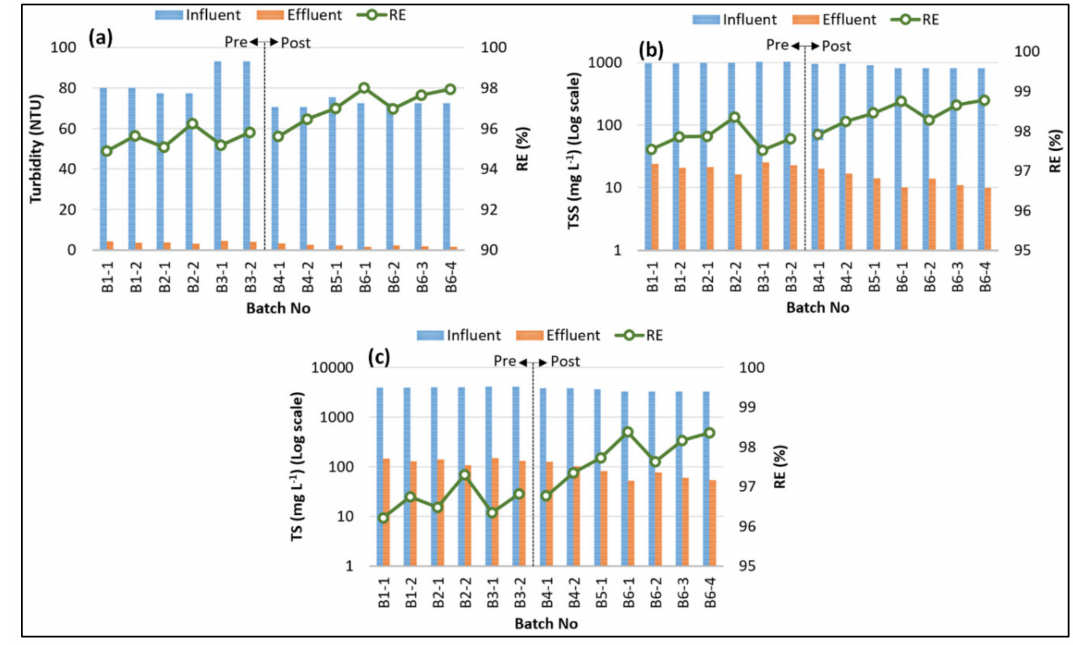
Figure 4. Variations and removal e ffi ciencies of ( a ) turbidity, ( b ) total suspended solids (TSS), and ( c ) total solids